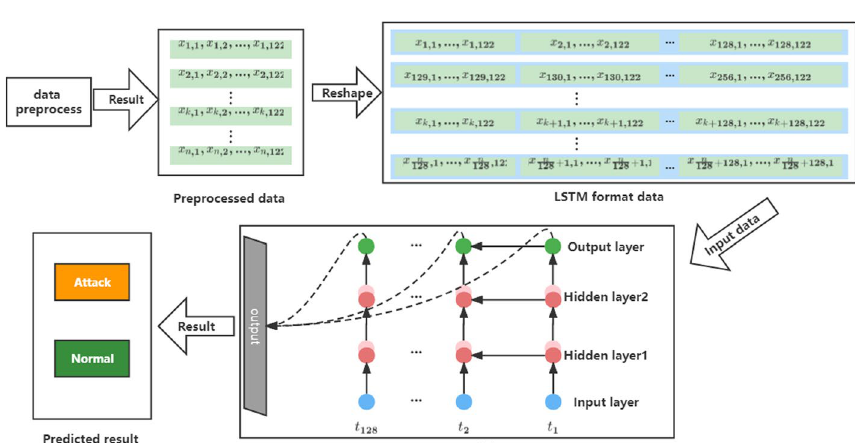
Fig. 5 Details of the designed LSTM